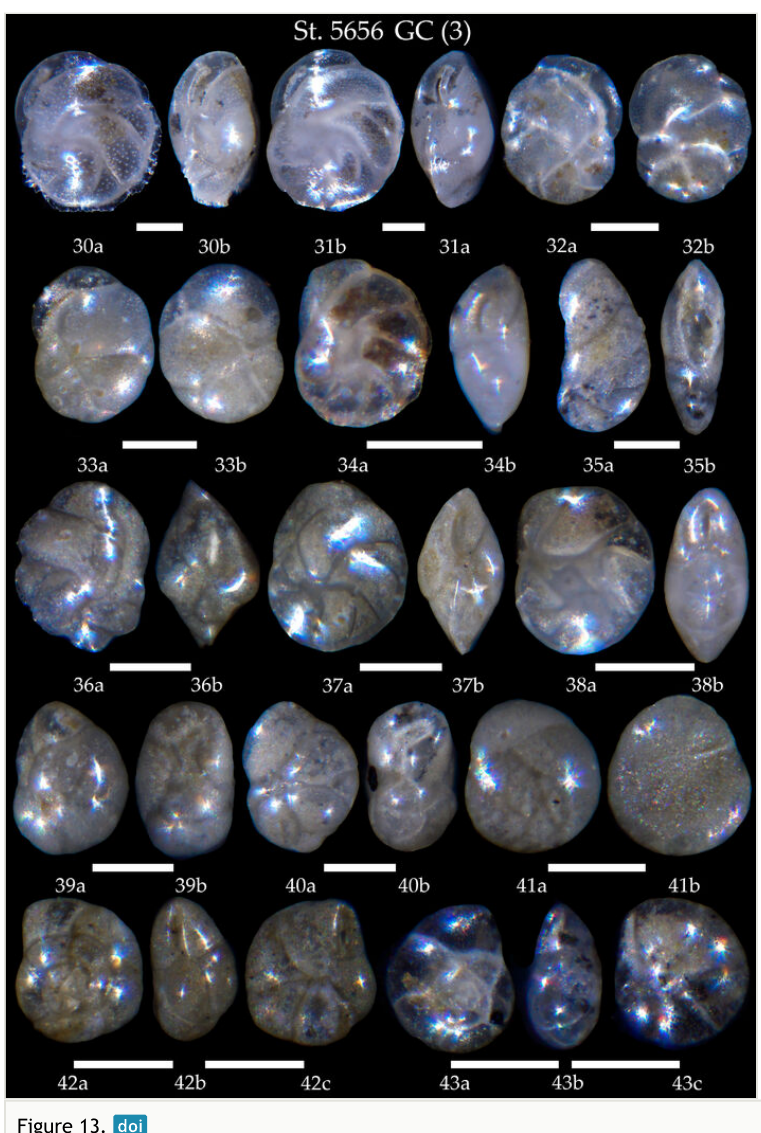
Figure 13. Station 5656 GC (continued). 30 Cassidulina carinata , a side view, b apertural view; 31 Cassidulina laevigata , a side view, b apertural view; 32 Cassidulina obtusa , a apertural view, b lateral view; 33 Cassidulina reniforme , a apertural view, b lateral view; 34 Cassidulina teretis , a side view, b apertural view; 35 Cassidulinoides bradyi , a side view, b apertural view; 36,37 Cassidulina sp. cf C. laevigata a side view, b apertural view; 38 Islandiella norcrossi , a side view, b apertural view; 39,40 Globocassidulina subglobosa , a side view, b apertural view; 41 Buccella frigida , a spiral view, b umbilical view; 42 Epistominella vitrea , a spiral view, b apertural view, c umbilical view; 43 Epistominella exigua , a spiral view, b apertural view, c umbilical view. Scale 100